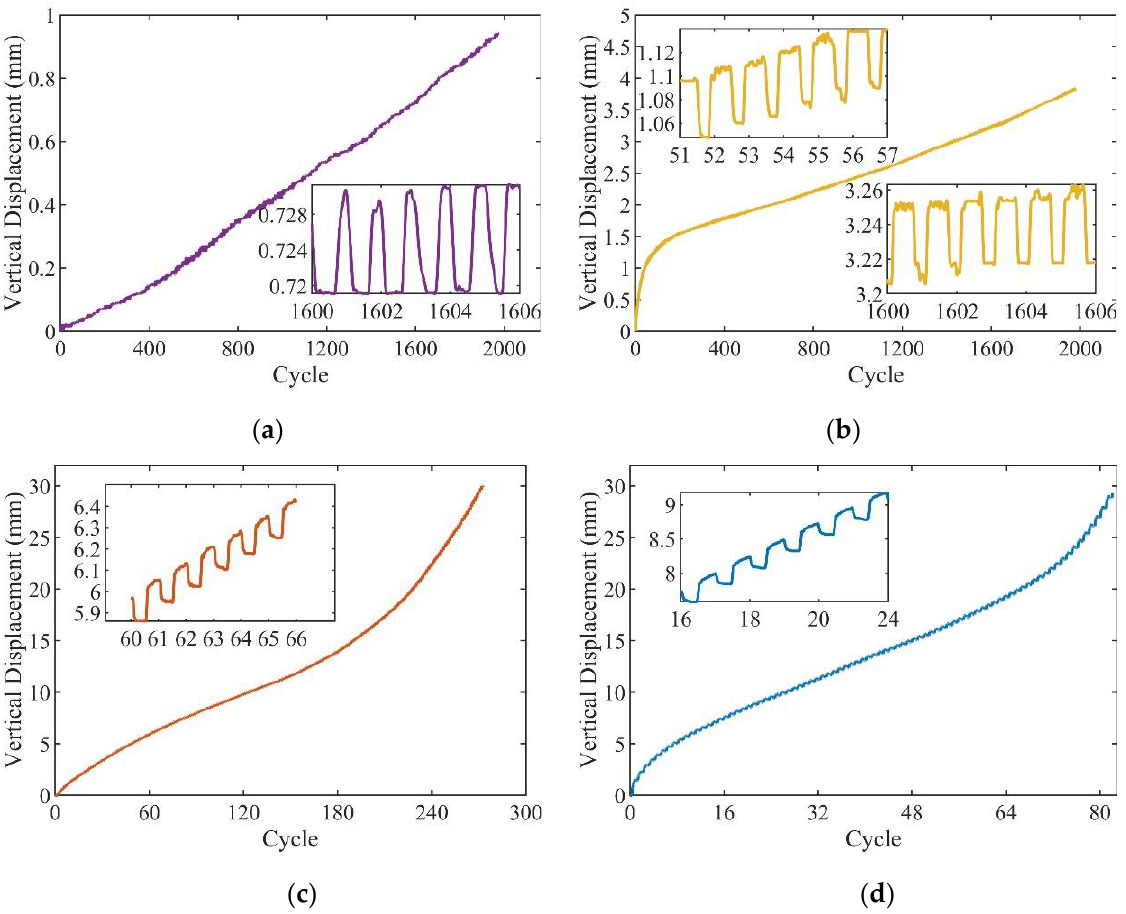
Figure 7. Time history of displacement of vertical cyclic loading with variable loading amplitudes: ( a ) Q C = 0.6 F max , ( b ) Q C = 0.8 F max , ( c ) Q C = 0.9 F max , ( d ) Q C = 1.0 F max